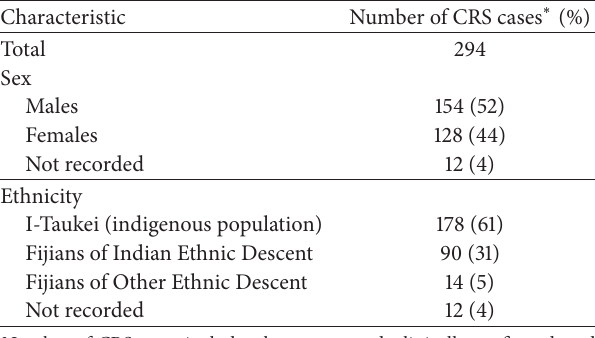
Table 1: Characteristics of infants with CRS in Fiji, 1995–2010.